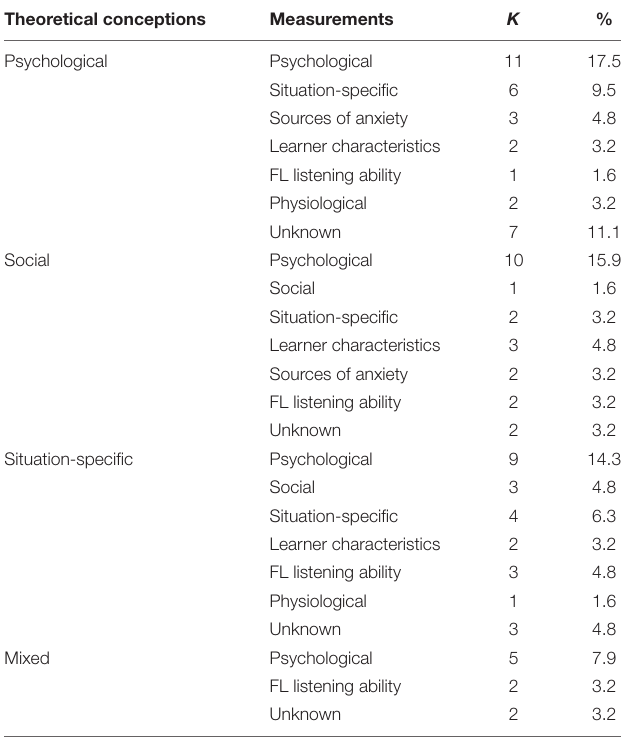
TABLE 4 | The relation between the theoretical conceptions and measurements of FL listening anxiety. Theoretical